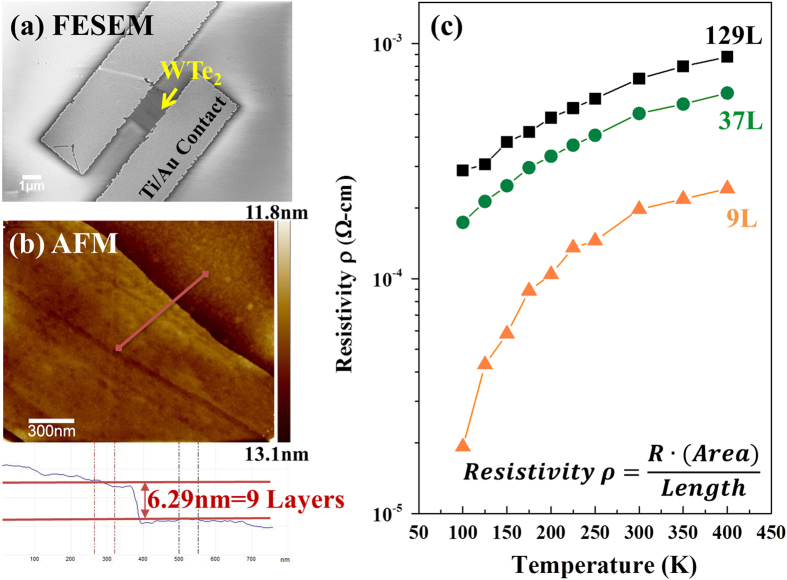
Representative (a) SEM and (b) AFM images of 9-layer (9L) Td-WTe2 Resistivity measurements as a function of temperature (c) confirm that Td-WTe2 is metallic in nature (resistivity proportional to temperature), rather than the semiconducting behavior recently suggested22282930.